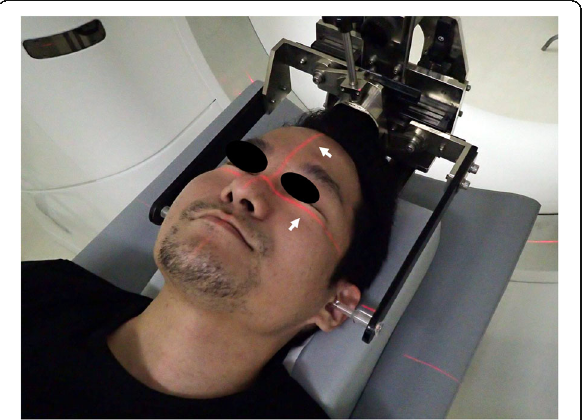
Fig. 2 Bilateral ear-rods made according to the cephalogram. The head position is defined using the ear rod and guide beam (arrow). Scanning with ear-rods helps to define the position of the head (parallelism) and makes STL data creation